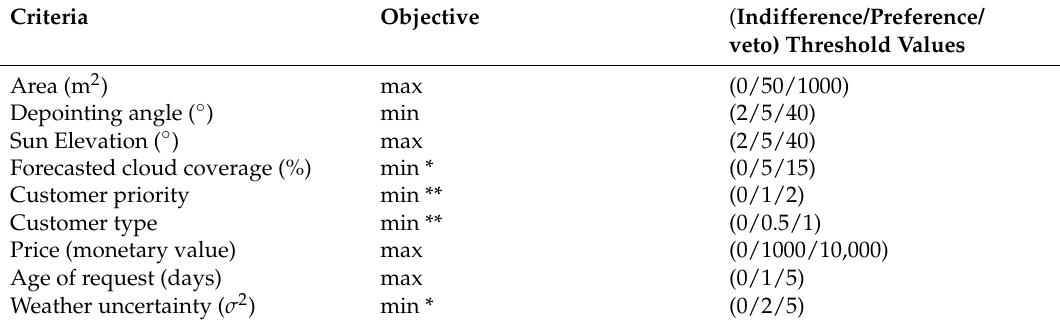
Table 3. The criteria utilized in the multi-criteria decision making (MCDM) scoring. * Note, it is the observed cloud cover that one really wants to minimize, but planning is conducted based on forecasts. ** This is an ordinal criteria, where a smaller number yields a higher value.